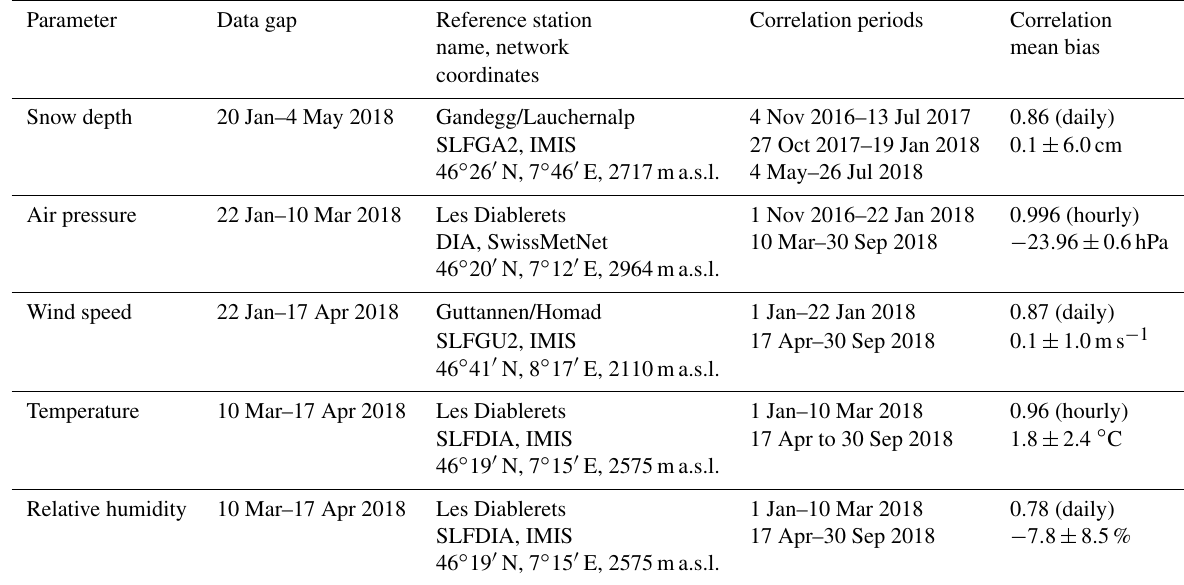
Table 3. Time periods of data gaps with reference periods for correlation and the correlation coefficients. The mean bias shows the average difference (and its standard deviation) between the reference stations and AWS at Plaine Morte. All stations are shown in Fig.